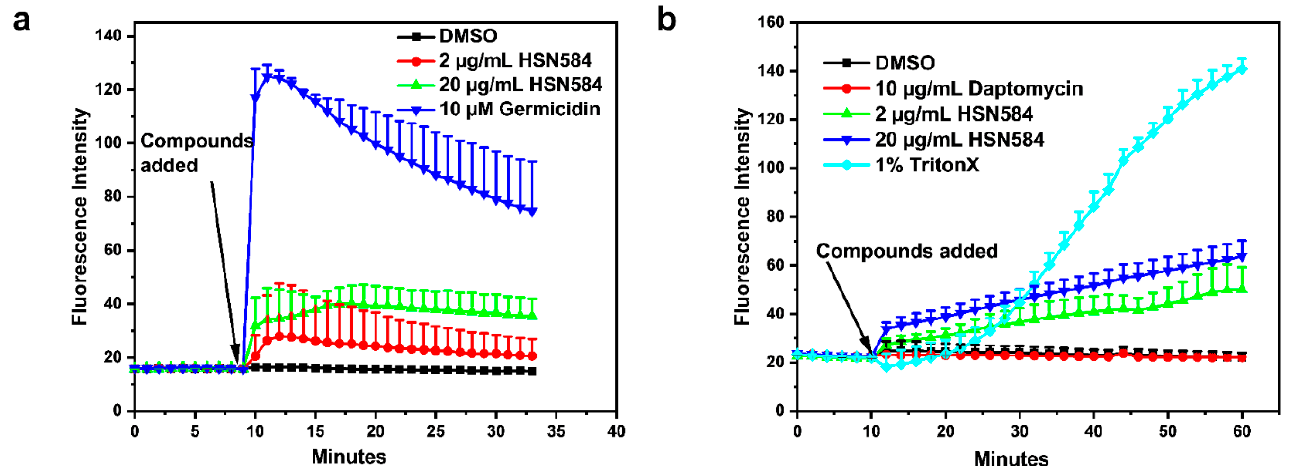
Figure 5. HSN584 effects on S. aureus ATCC 25923 membrane integrity. ( a ) HSN584 effects on membrane polarization. Germicidin (positive control); DMSO (negative control). ( b ) HSN584 effects on membrane permeation. A 1% TritonX (positive control); DMSO and Daptomycin (negative controls).